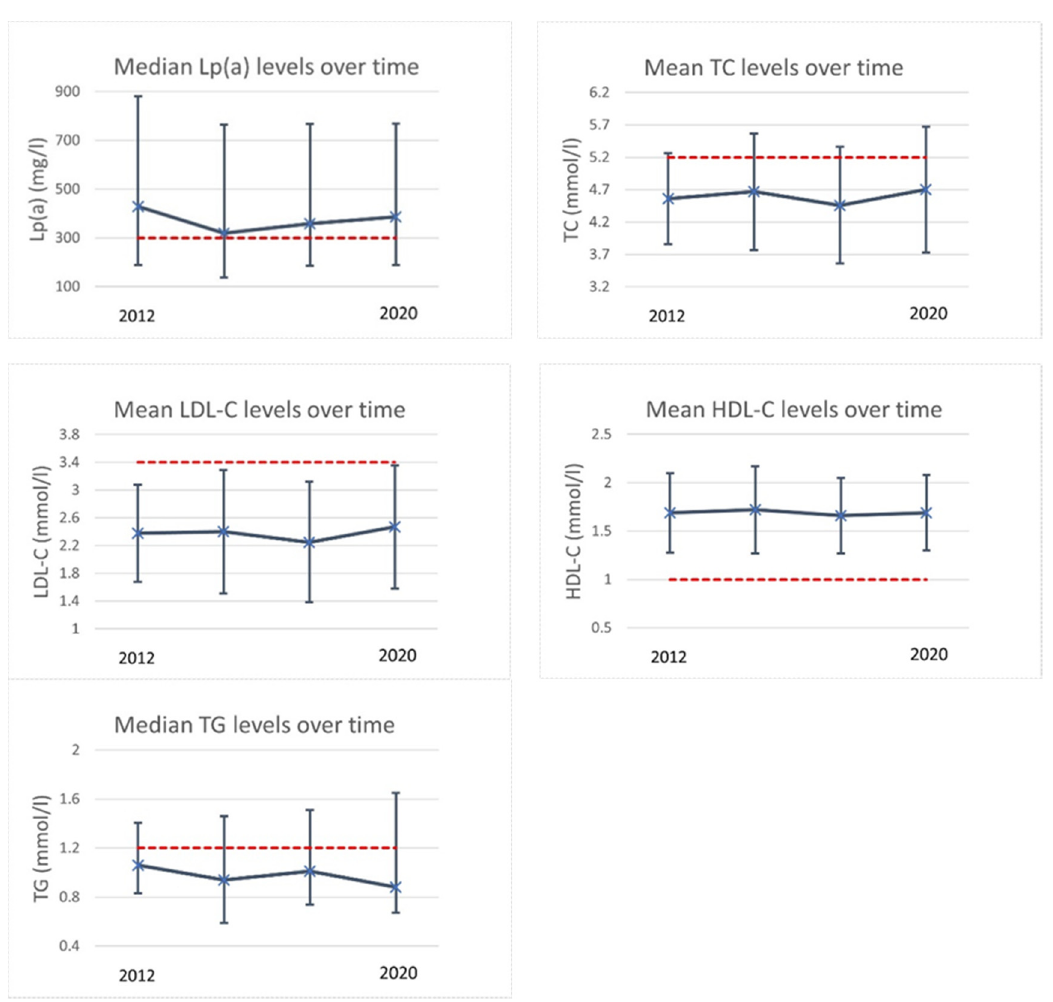
Figure 1. Lipid trends in retrospective longitudinal substudy. This figure shows the lipid trends of all 36 participants in the retrospective longitudinal substudy. Values are either median with interquartile range or mean with +/- one standard deviation. Red dashed lines show the reference values. Reference values were: Lp(a) > 300 mg/L, TC ≥ 5.2 mmol/L (200 mg/dL), LDL ≥ 3.4 mmol/L (130 mg/dL), HDL ≤ 1 mmol/L (40 mg/dL), TG ≥ 1.2 mmol (110 mg/dL) for children aged < 10 years and ≥ 1.7 mmol (150 mg/dL) for children aged ≥ 10 years. Abbreviations: HDL-c = high-density lipoprotein cholesterol; LDL-C = low-density lipoprotein; Lp(a) = lipoprotein(a); TC = total cholesterol; TG = triglycerides.